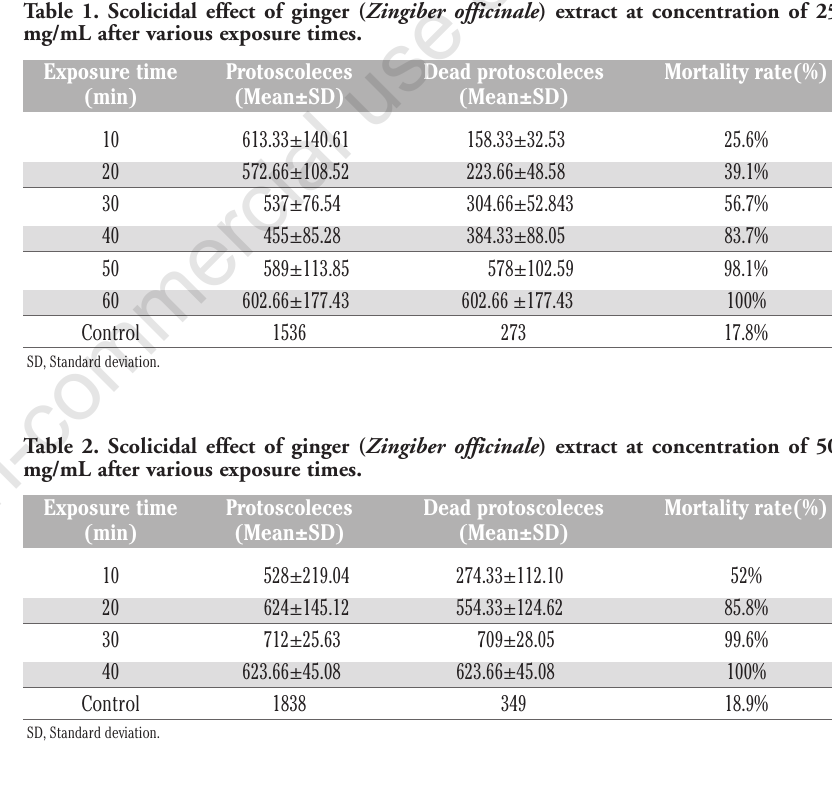
Table 3. Scolicidal effect of ginger ( Zingiber officinale ) extract at concentration of 100 mg/mL after various exposure